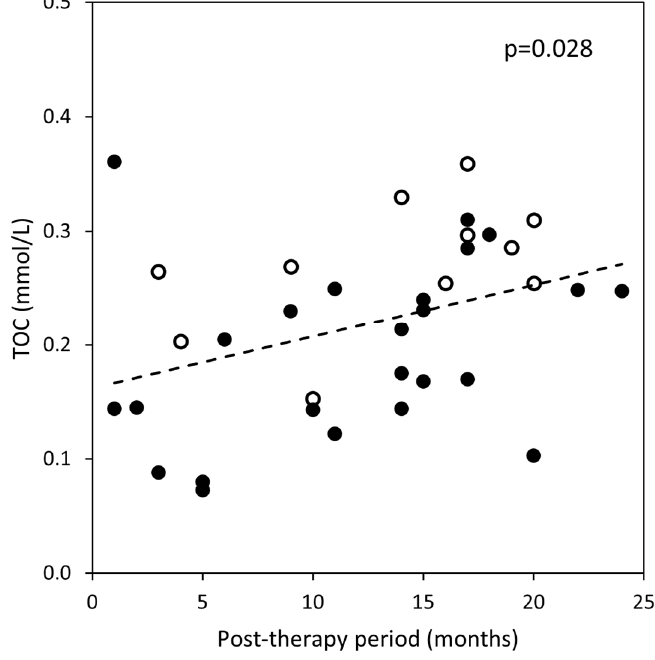
Figure 2. Spearman’s correlation between serum concentrations of TOC (total oxidant capacity) and the post-therapy period in bone tumor survivors ( ○ with osteosarcoma; ● with Ewing’s sarcoma).